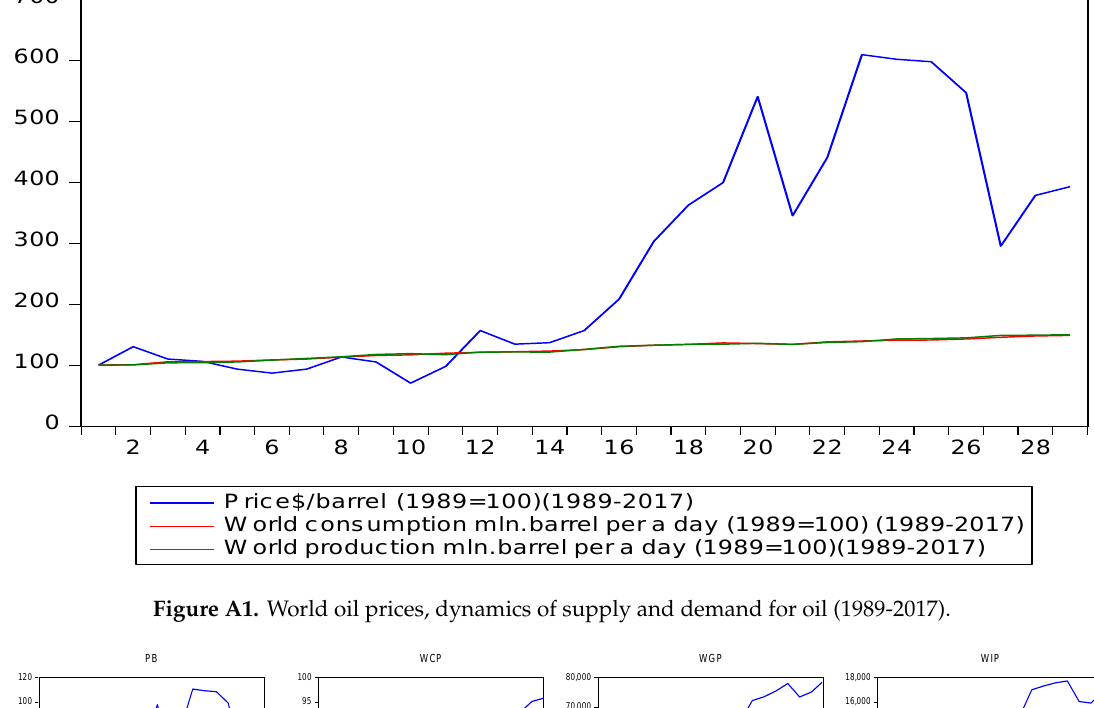
Figure A1. World oil prices, dynamics of supply and demand for oil (1989-2017).